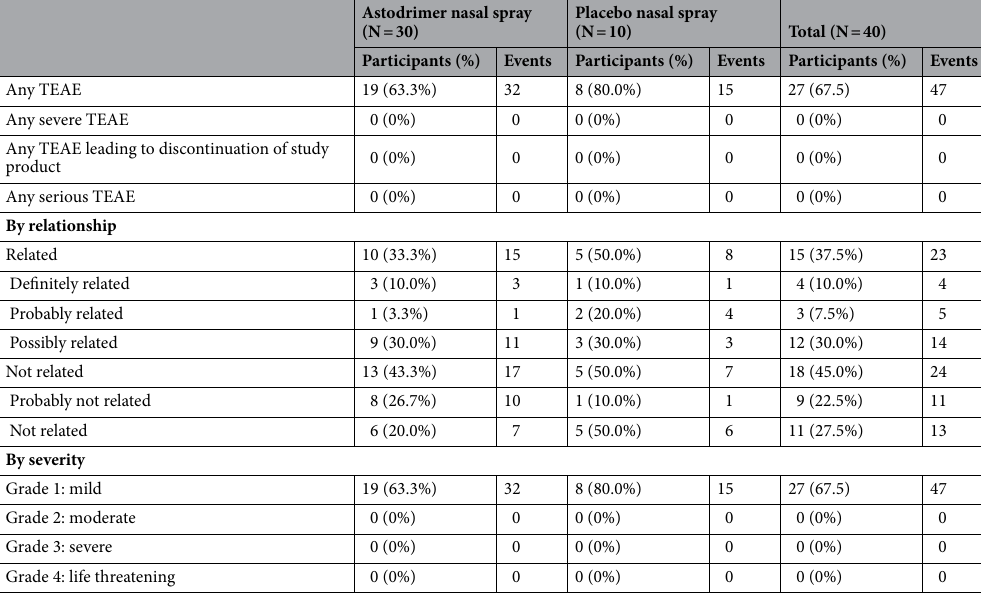
Table 2. Overall summary of treatment emergent adverse events. TEAE treatment emergent adverse